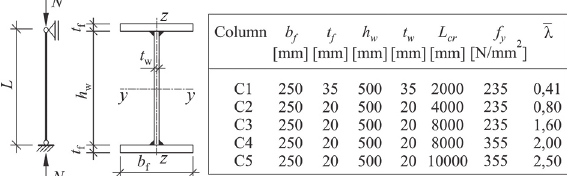
Fig. 11. Procedure of calculation of residual stresses for i cross-section in step b